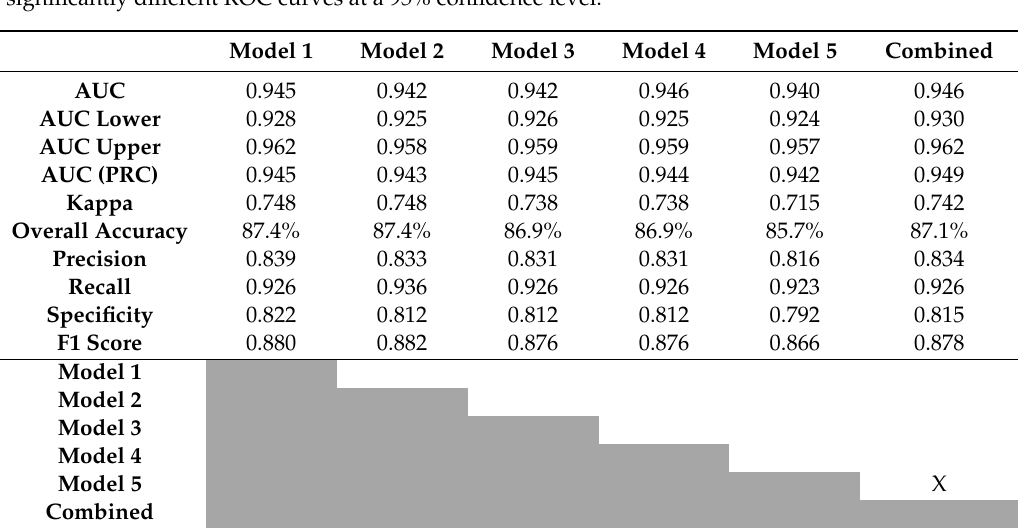
Table 5. Results for each model and the combined model. Lower and upper bounds represent a 95% confidence interval calculated using 2000 stratified bootstrap replicates. X indicates statistically significantly di ff erent ROC curves at a 95% confidence